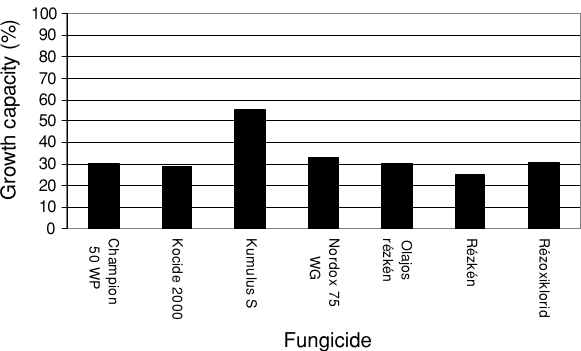
Figure 1. Percent growth capacity of Spilocaea pomi for 7 fungicides (organically approved) admended on PDA plates at 1 × dosage recommended by the manufacturer (LSD